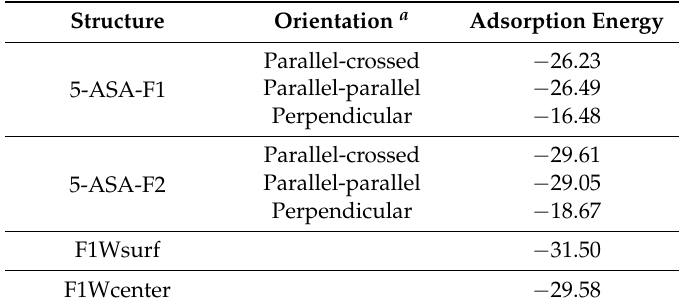
Figure 3. Adsorption of the conformer F1 of 5-ASA placed parallel to the surface in a crossed configuration in the halloysite after its optimization. Views from the (001) ( a ) and (010) ( b ) crystallographic planes. Table 2. Adsorption energy (in kcal/mol) of the halloysite/5-ASA complexes. Table 2. Adsorption energy (in kcal/mol) of the halloysite/5-ASA complexes.